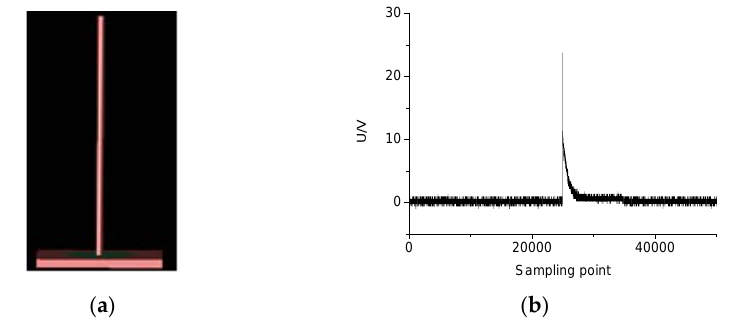
Figure 14. Antenna sensor and pulse source: ( a ) Antenna sensor; ( b ) Pulse source.